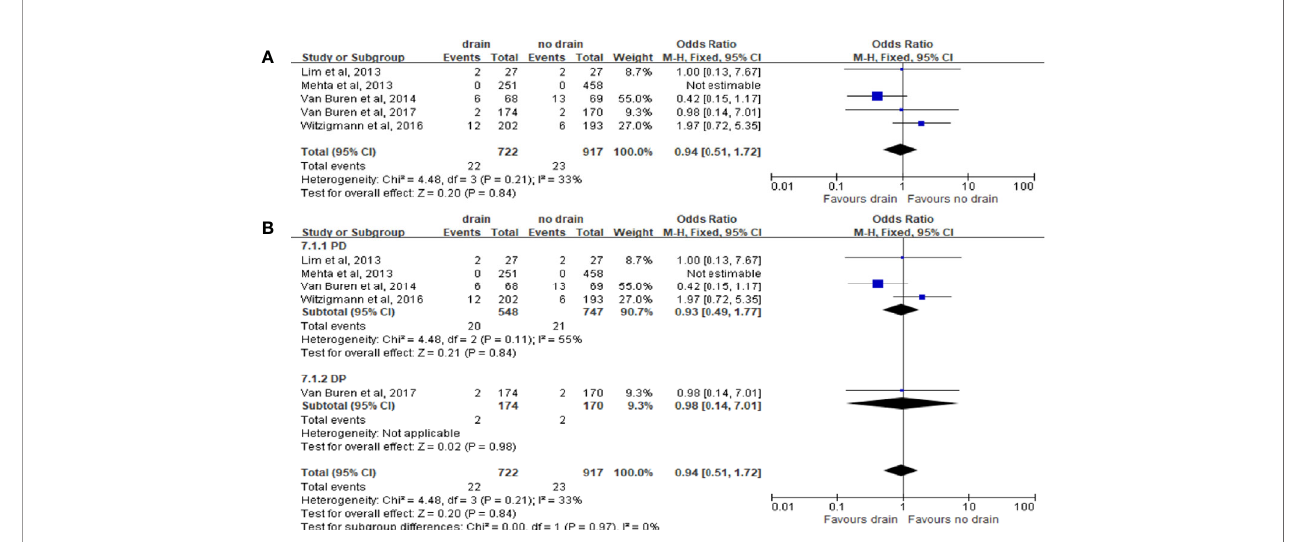
FIGURE 9 | Forest plot of the comparison of the rate of hemorrhage in drain versus no-drain groups after pancreatic resection. (A) Comparison in overall; (B) comparison in PD and DP subgroups,